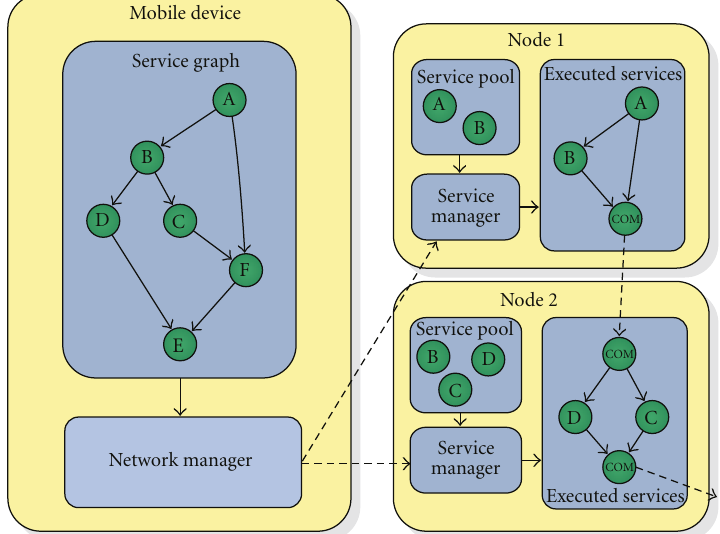
Figure 4: Mapping of a service graph (whose definition resides in the mobile device) onto the Titan nodes. Parts of the service graph are configured onto each participating node, depending on their sensors or computational capabilities. Interconnections across sensor nodes are realized over automatically inserted communication